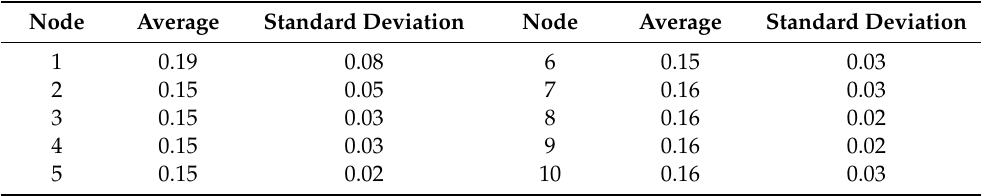
Table 3. Root mean square error (RMSE) of ANN by